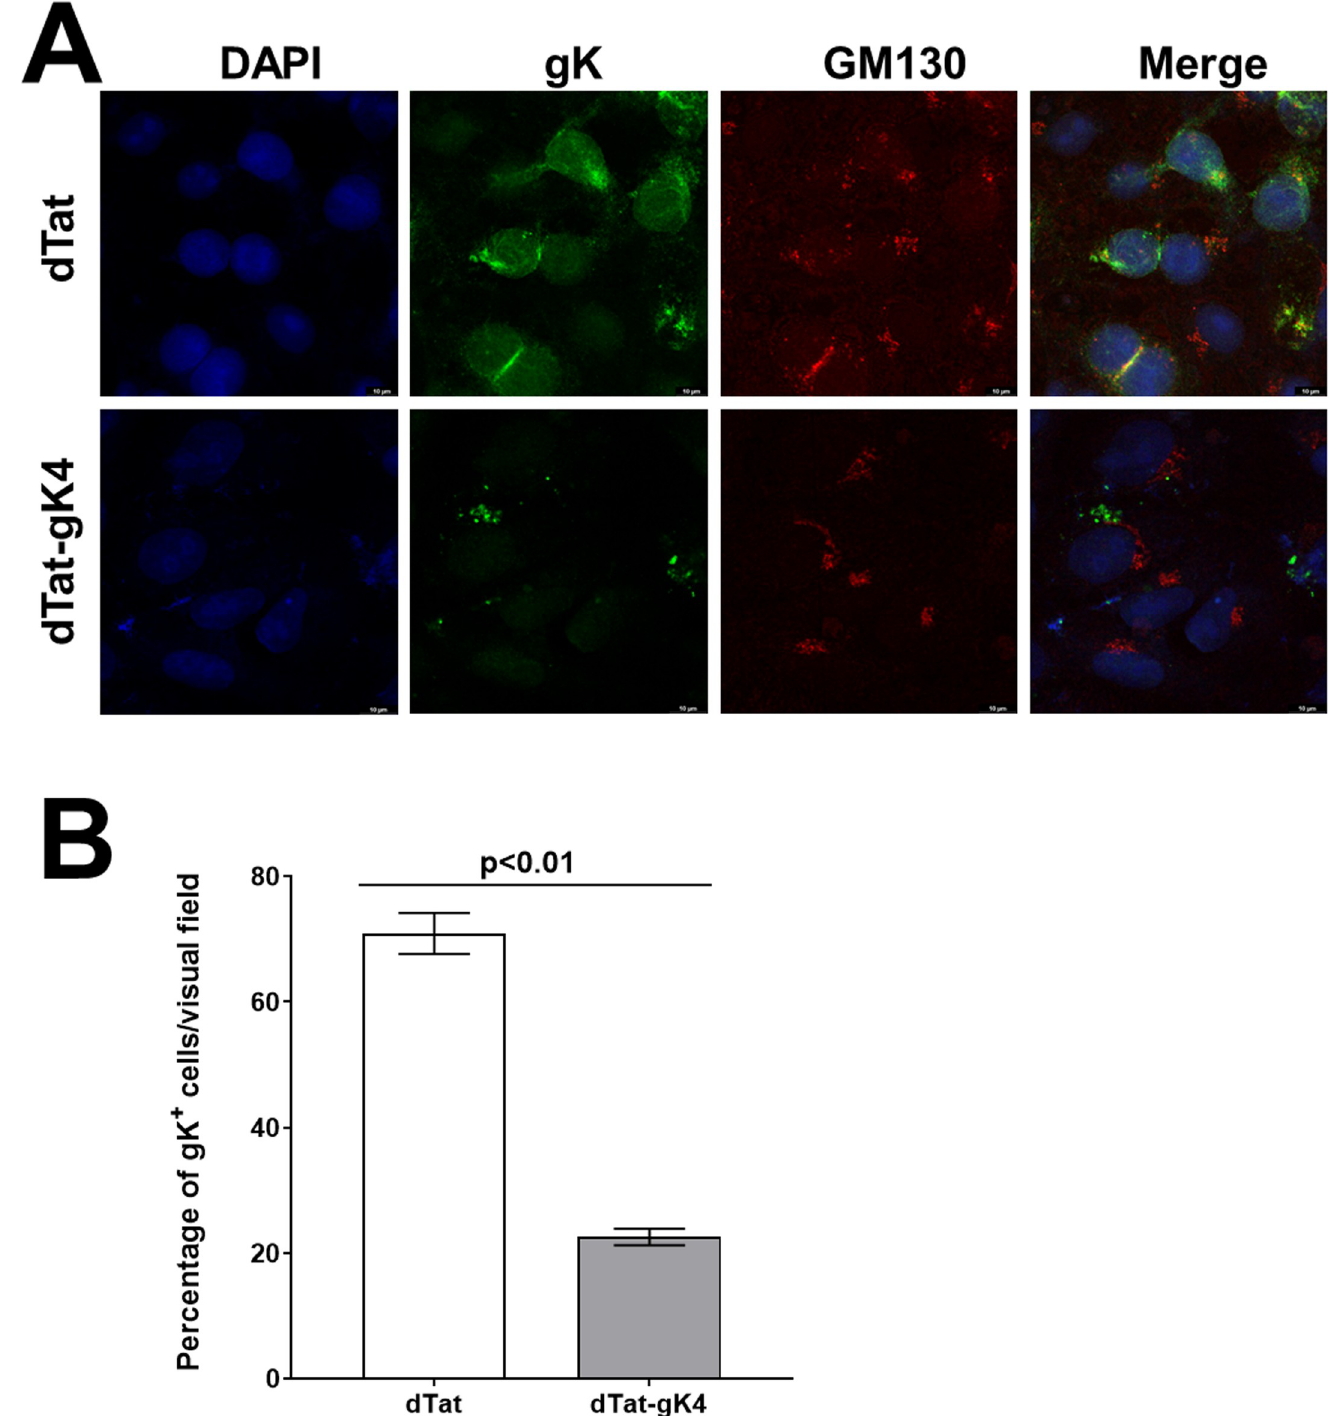
Fig 5. Effect of blockade of gK interaction with SPP using gK4 on gK localization in HSV-1 infected cells. A) Detection of HSV-1 gK in infected cells. Vero cells grown to confluency on chamber slides were infected with 1 PFU/cell of VC1 virus in the presence of 20 μ g/ml of dTatgK4 or dTat peptide for 1 hr. After 1hr infection, the media was replaced with fresh media containing each peptide for 16 hr. Infected cells were fixed and immunostained using anti-V5 (for gK) with anti- GM130 (for Golgi), and chicken anti-goat AlexaFluor 488 (for gK) with chicken anti-rabbit AlexaFluor 594 (for GM130) as secondary antibodies. DAPI was used for nuclear staining (blue). There were fewer gK positive cells in the dTat-gK4 treated group than in control dTat peptide-treated group. gK protein colocalized with Golgi protein GM130 in the control peptide group, indicating enrichment of gK protein in the Golgi apparatus. However, gK protein did not colocalize with GM130